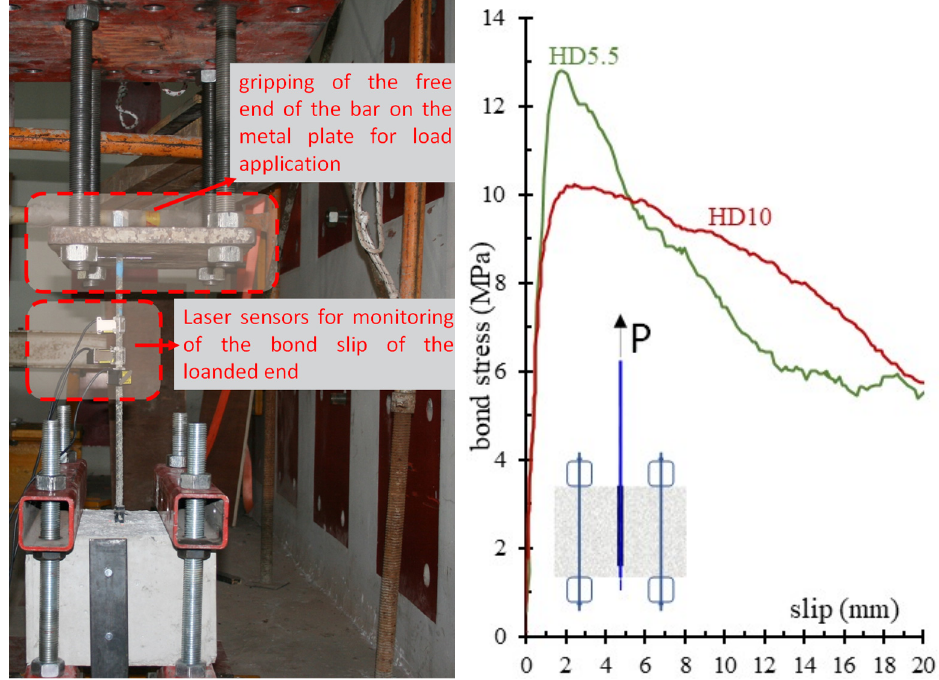
Figure 8. Test rig, instrumentation and results of the pull-out tests.